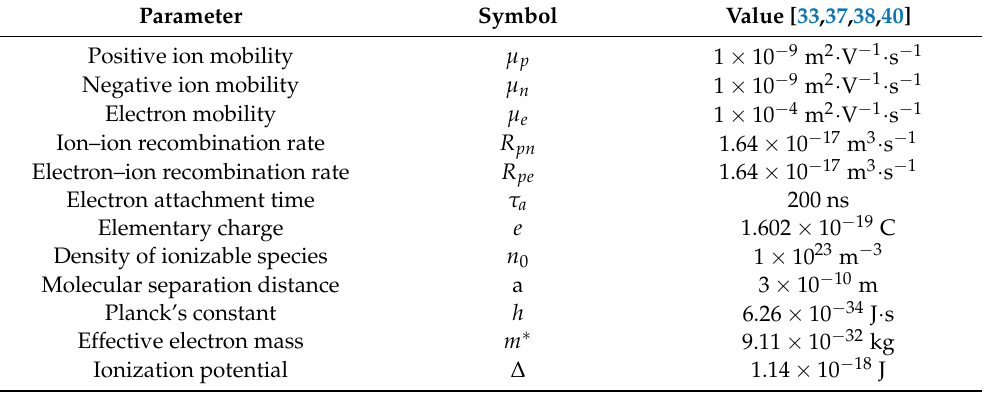
Table 1. Parameter values for the streamer model in transformer